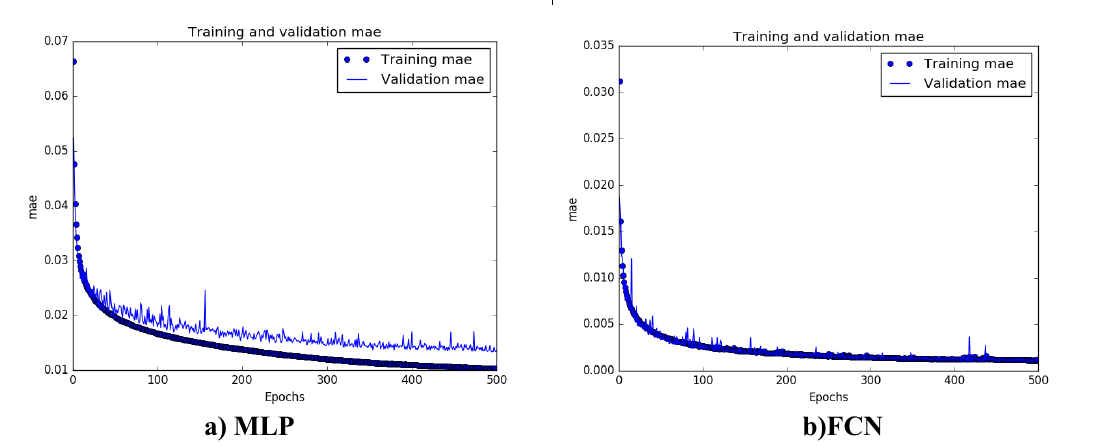
Figure 4. The evolution of MAE with training of two